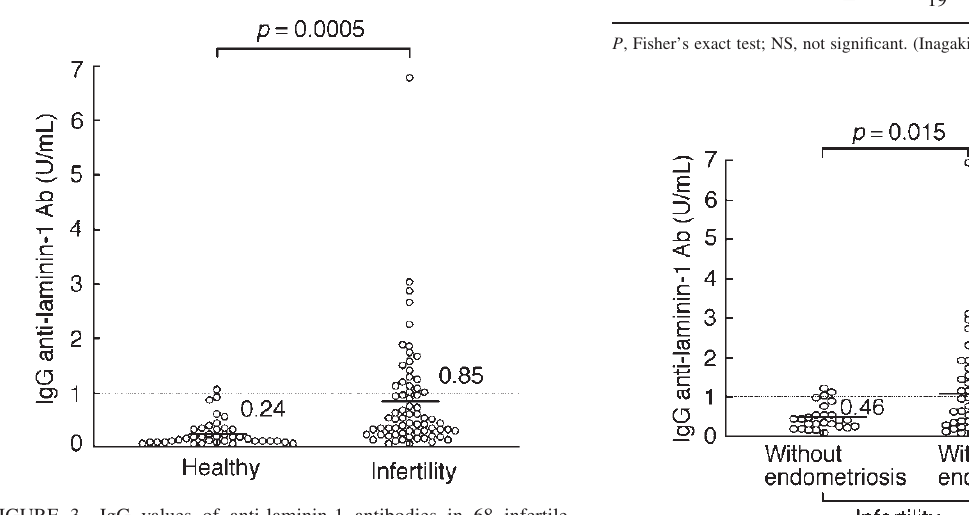
FIGURE 3 IgG values of anti-laminin-1 antibodies in 68 infertile patients who underwent laparoscopy or laparotomy. Anti-laminin-1 antibodies were detected in ELISA using a laminin-1-coated plate. The dotted line shows 1U/ml (1U/ml ¼ OD, the mean þ 3 SD of healthy non-pregnant women), as a cut off value of the antibodies. Solid lines show the mean value. (Inagaki et al. , 2003).